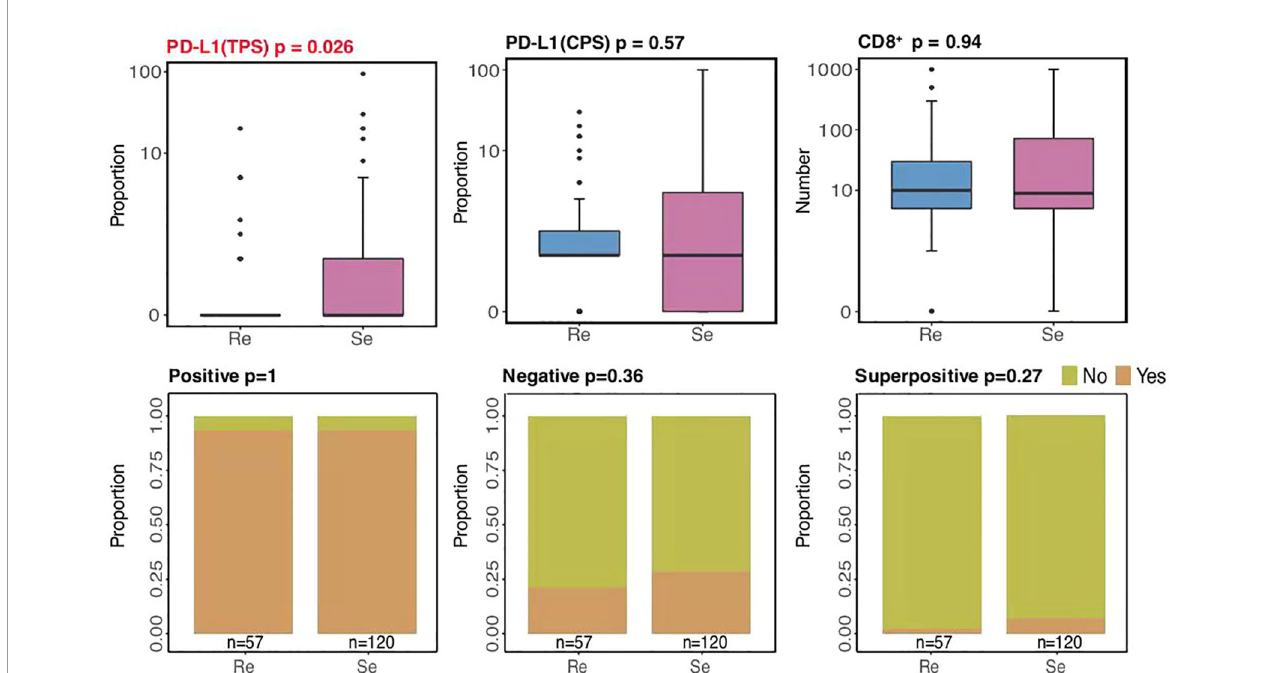
FIGURE 5 | Comparison of immunotherapy-related